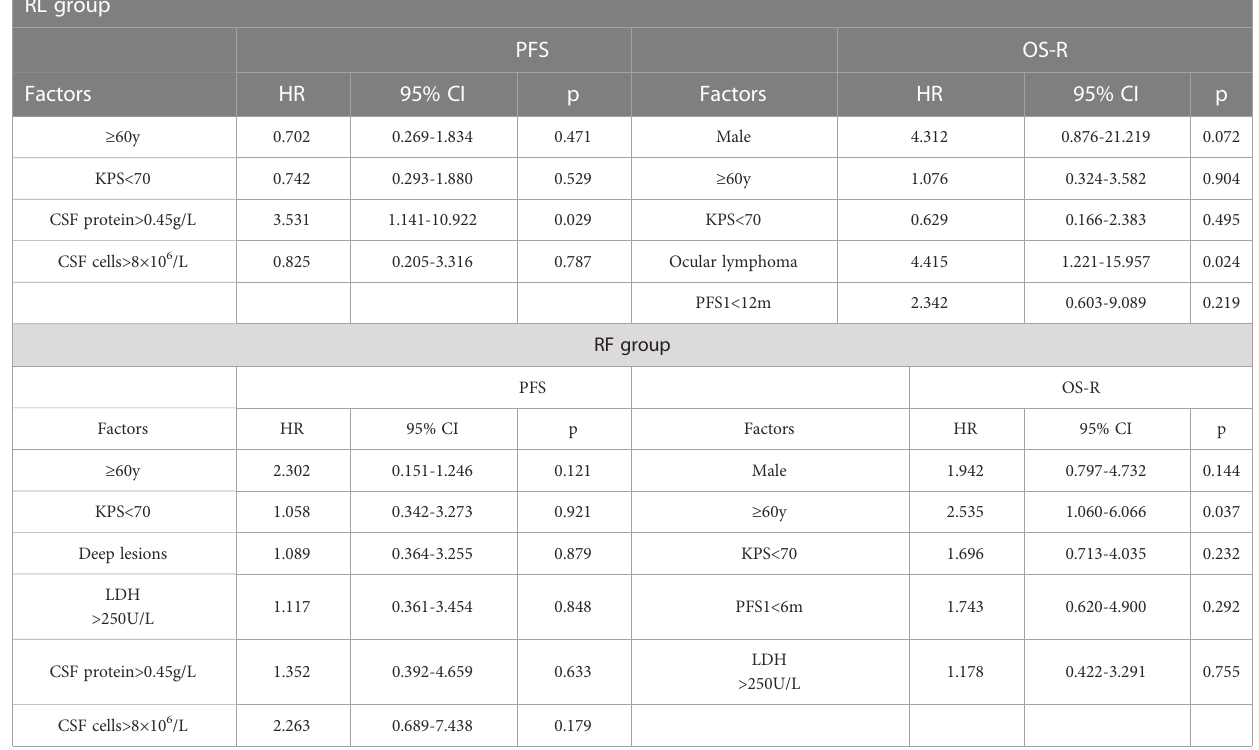
TABLE 5 Multivariate analysis of prognostic factors for relapsed and refractory PCNSL. RL